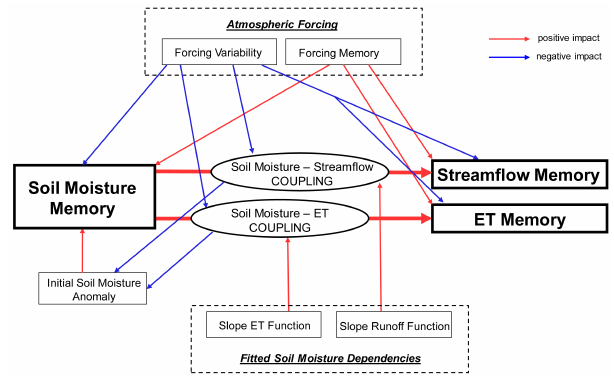
Figure 7: Schematic view of propagation of soil moisture memory to streamflow memory and ET memory. Red Fig. 7. Schematic view of propagation of soil moisture memory to arrows denote positive impacts, blue arrows show negative impacts. Only dependencies investigated in this study streamflow memory and ET memory. Red arrows denote positive are shown. impacts, blue arrows show negative impacts. Only dependencies in- vestigated in this study are